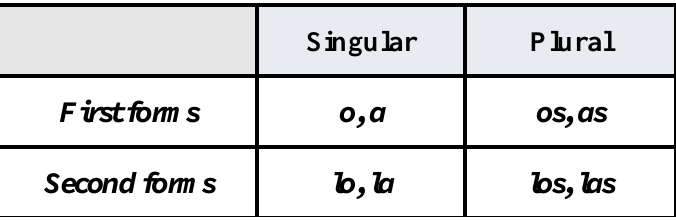
Table 1. Morphological forms of clitics and determiners in